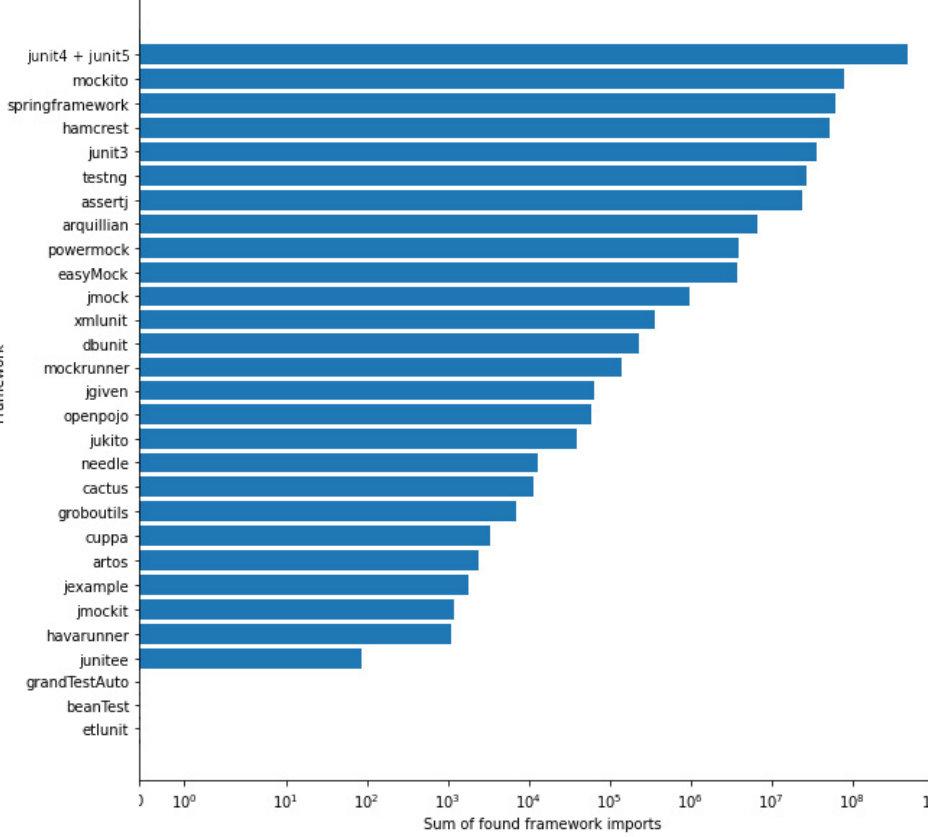
Figure 8. The number of found framework imports in all java files (logarithmic